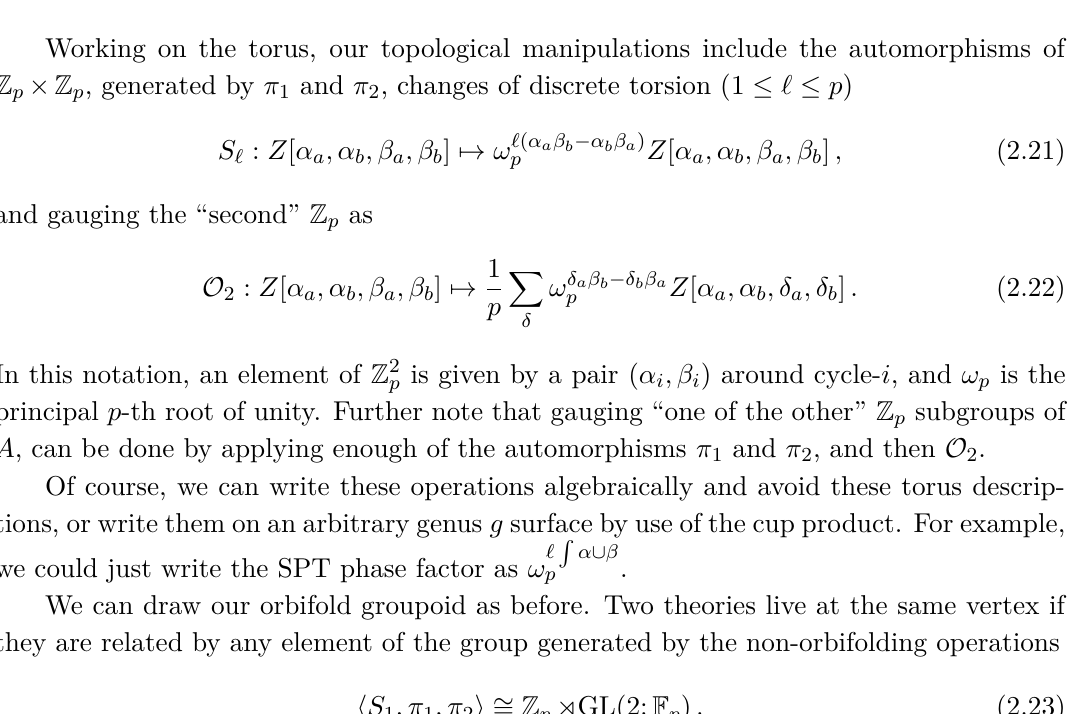
Z . Edges correspond to gauging a Z 3 × 3 p +1 ,p +1